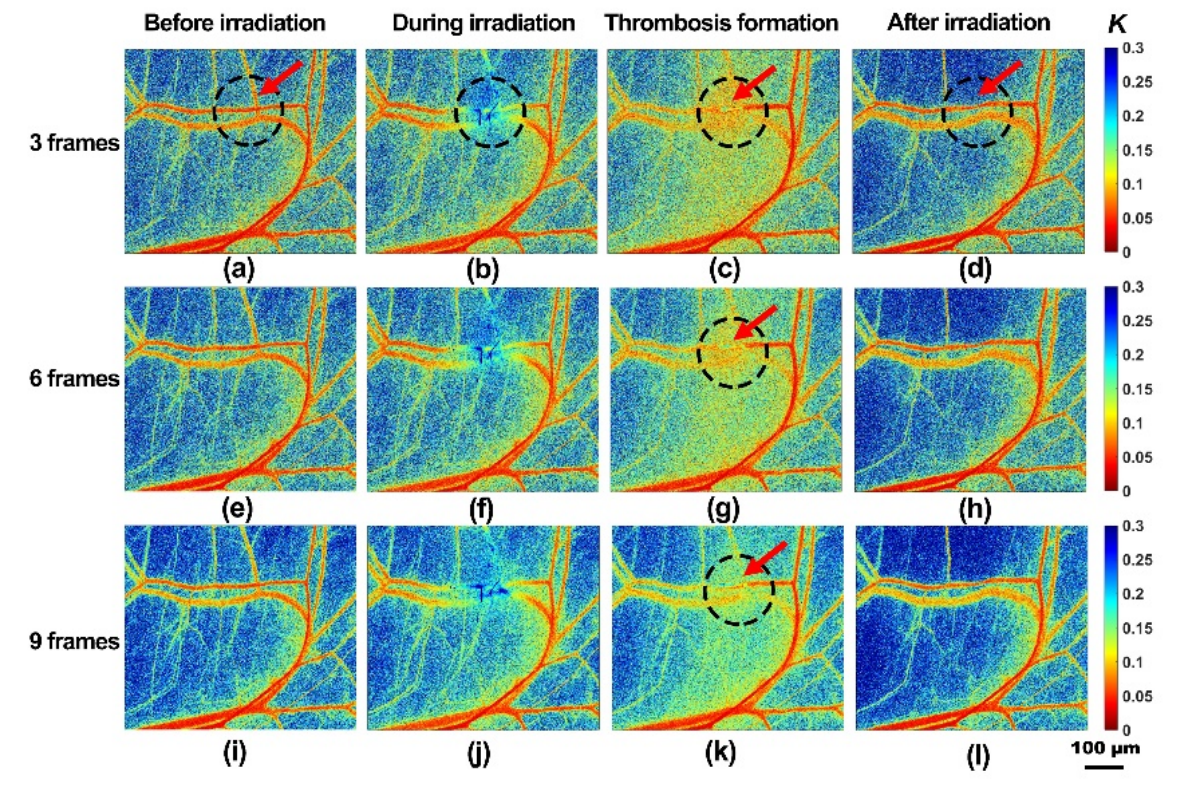
Figure 7. Real-time monitoring of blood flow and thrombosis formation by using the tLSCI algorithm. ( a , e , i ) Before irradiation with 3, 6, 9 frames, respectively, ( b , f , j ) During irradiation with 3, 6, 9 frames, respectively, ( c , g , k ) Thrombosis formation with 3, 6, 9 frames, respectively, ( d , h , l ) After irradiation with 3, 6, 9 frames, respectively.